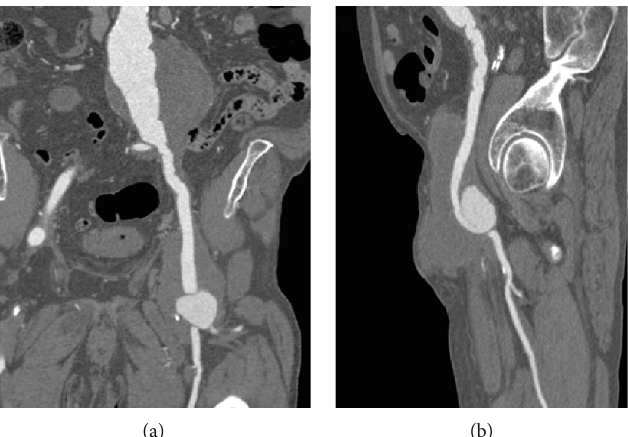
Figure 2: Patient ’ s CT angiography on admission: (a) asymptomatic 11cm juxtarenal abdominal aortic aneurysm with partially thrombosed 65 × 55 mm pseudoaneurysm in the left groin; (b) partially thrombosed 65 × 55 mm pseudoaneurysm in the left